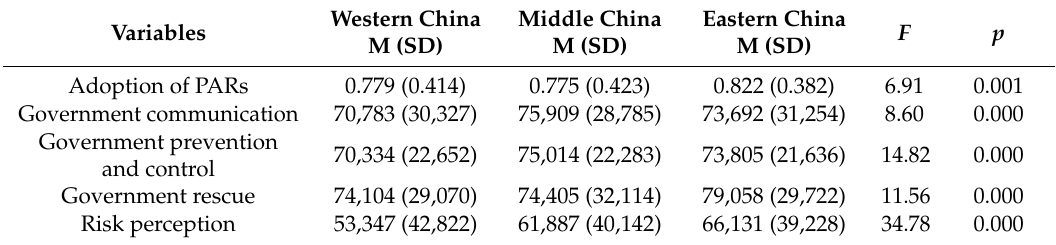
Table A2. One-way ANOVA results: Di ff erences between Western China, Middle China, and Eastern